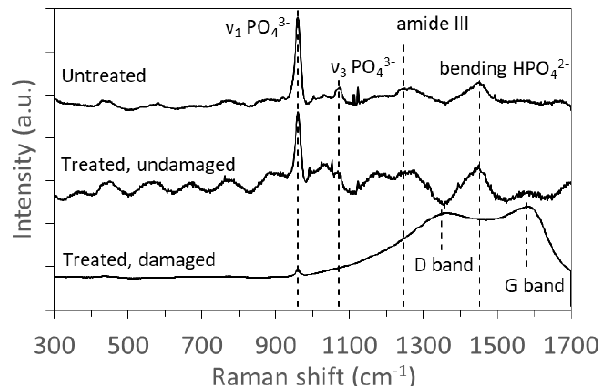
Figure 6. Normalized Micro-Raman spectra of untreated bone, and laser-ablated samples without visible thermal damage (treated, undamaged) and with visible thermal damage (threated, damaged).